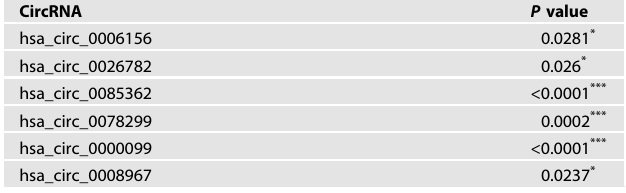
Fig. 1 Identi fi cation of circTRPS1-2 through high-throughput sequencing of ESCC tissues. a Circos plot showing the chromosome positions of all circRNAs identi fi ed in ESCC tissues. b Differences in expression of circRNAs between ESCC and adjacent normal esophageal tissues. c Heatmap showing differences in expression of 41 circRNAs downregulated in ESCC tissues and 5 circRNAs upregulated in ESCC tissues. Differences are expressed as log (CPM) as calculated by EdgeR. d Volcano plot showing 10 circRNAs downregulated in ESCC tissues and 5 upregulated circRNAs. The circRNA hsa_circ_0085362 is marked. Grey indicates no signi fi cant difference; green, P ≥ 0.05 and | FC | ≥ 2; and red, P < 0.05 and | FC | ≥ 2, which served as the de fi nition of differential circRNA expression. C or Cancer, ESCC tissue; CPM, counts per million; ESCC, esophageal squamous cell carcinoma; FC, fold change; N or Normal, adjacent normal esophageal tissue. Table 1. P values associated with the difference in expression of certain circRNAs between ESCC and adjacent normal tissue in 30 matched pairs of